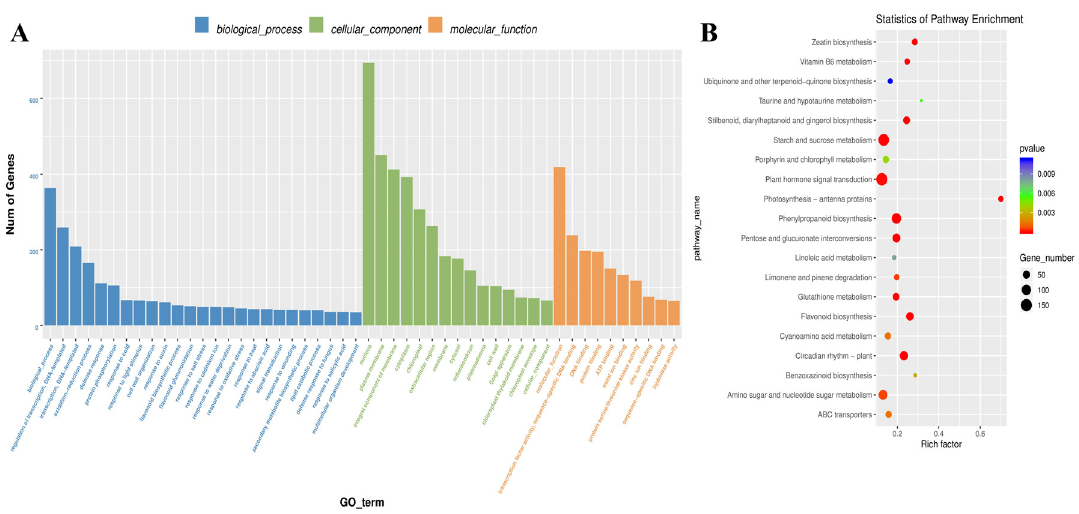
Figure 3. Gene classification was based on Gene Ontology (GO) analysis for differentially expressed genes (DEGs). Different classes are shown for biological processes, cellular components, and molecu- lar functions ( A ). The Kyoto Encyclopedia of Genes and Genomes (KEGG) pathway of DEGs. The pathway names are provided on the vertical axis. The rich factor in the horizontal axis is the size of the point, which represents the number of DEGs, and the color of the dot represents the q value ( B